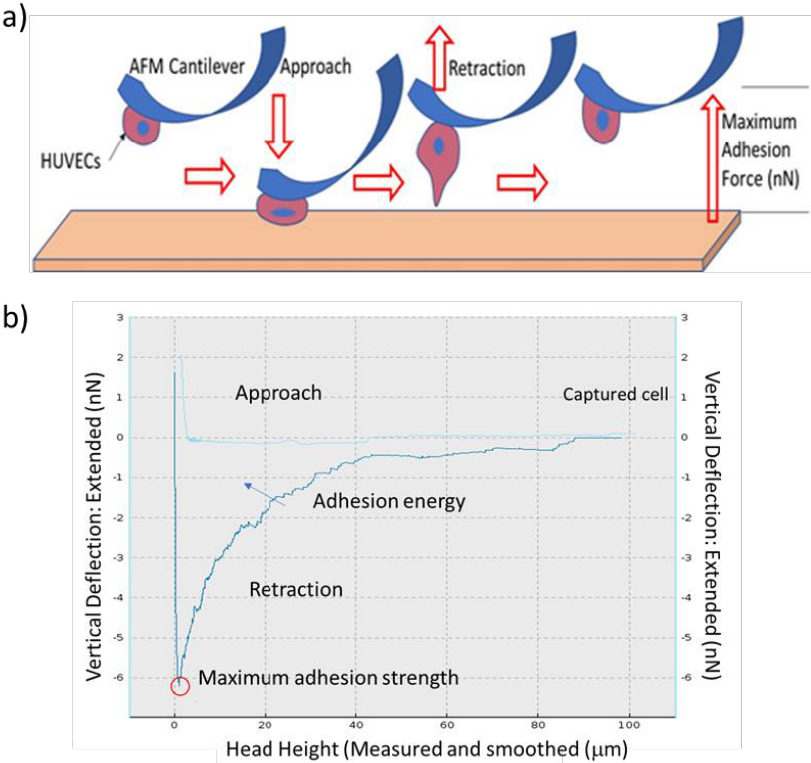
Figure 3. Schematic of ( a ) cell – substrate interaction measurement. ( b ) A force – distance (F-D) curve recorded with the CellHesion AFM technique.